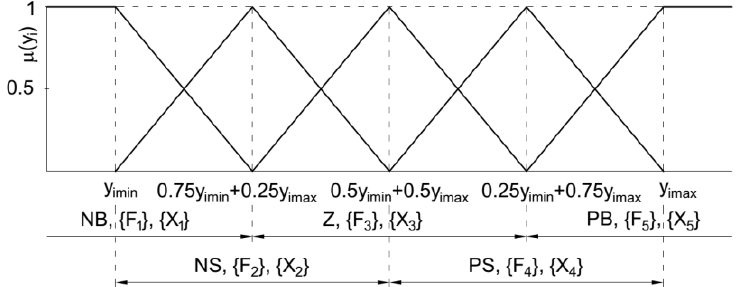
Figure 4. The membership function of position error, velocity error and adjustment amount of driving torque of joint i: y i (y i = e i , e i , u i ; i = 1, …, 8).